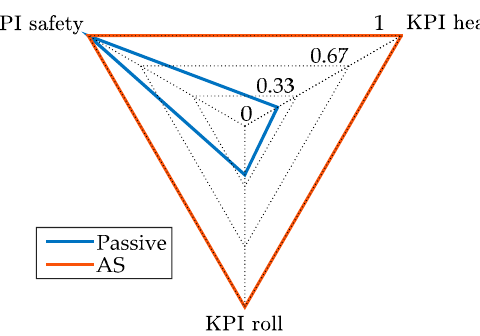
Figure 12. Key performance indexes improvement for the sine sweep test. The hydraulic active suspension (AS) allows for improved driving comfort with simultaneous preservation of the active safety requirements.